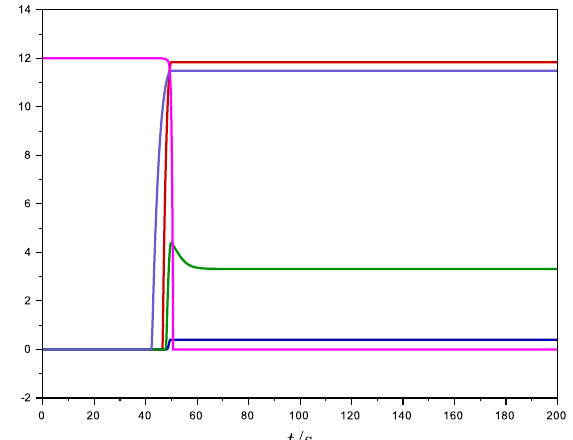
Figure 15. Logarithmic plot of the relative concentrations (in units 10 − 12 ) for the products of decarboxylation (red), dimerization (blue), dehydration (green), and degassing (lavender) of glycine in a micrometeorite with v 0 = 3.7 km s − 1 , R 0 = 70 µ m, and θ 0 = 45.0